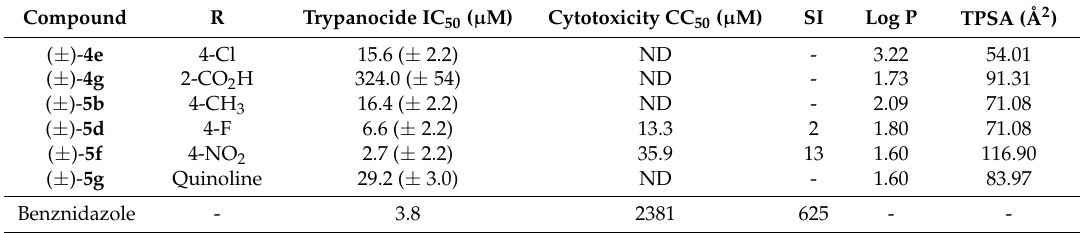
Table 3. In vitro trypanocidal activity, cytotoxicity and selectivity index (SI) of bioactive xylitan derivatives. Compound R Trypanocide IC 50 ( µ M) Cytotoxicity CC 50 ( µ M) SI Log P TPSA (Å 2 )